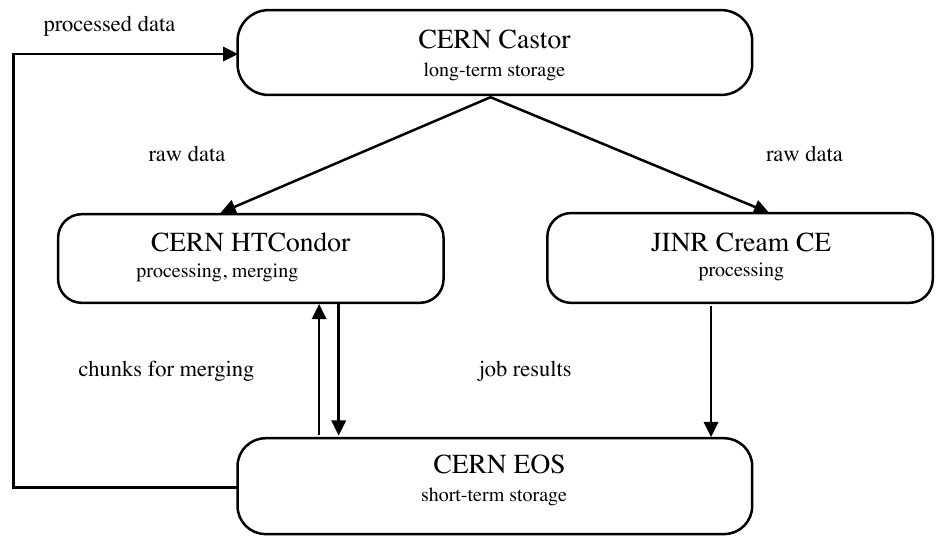
Fig. 2. COMPASS data processing work